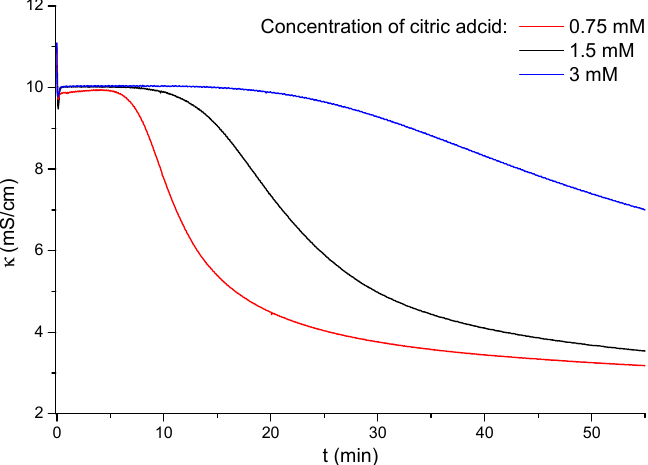
Figure 6. Variation of conductivity in the reaction of MgSO 4 + Ca(OH) 2 + 2 H 2 O → Mg(OH) 2 + CaSO 4 ·2H 2 O with 0.1-M initial reactant concentration, using different amounts of citric acid as inhibitor (T = 20 °C; in distilled water media without any supporting electrolyte).